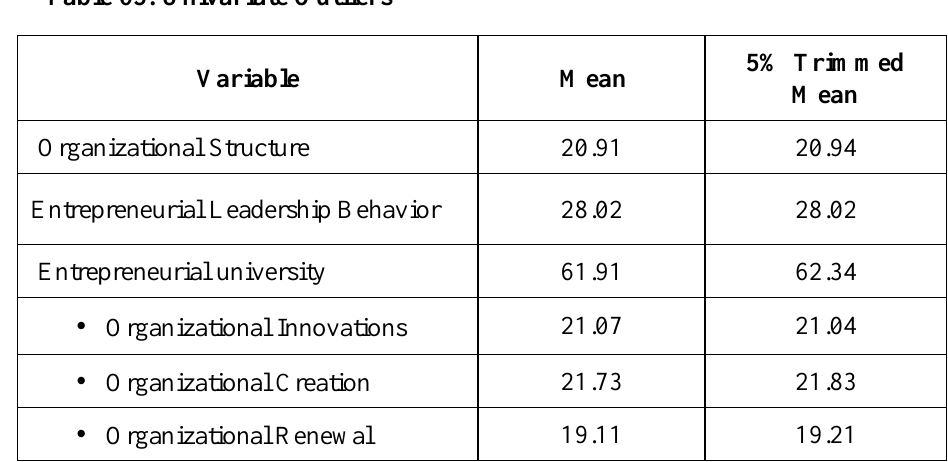
Table 05: Univariate Outliers